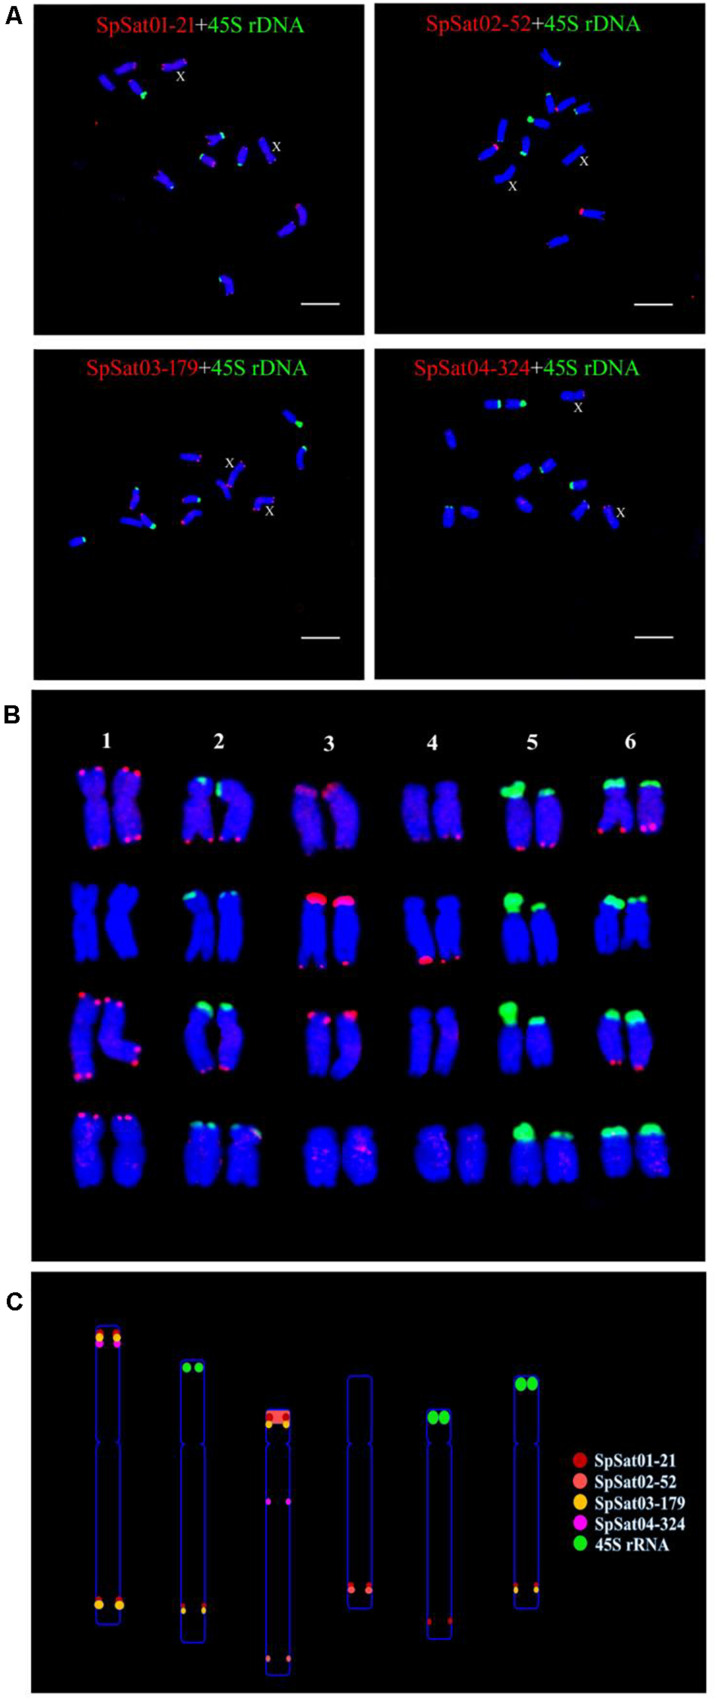
Karyotype and ideograph for spinach mitotic metaphase chromosomes. (A) FISH analysis of SpSat01-21, SpSat02-52, SpSat03-179, and SpSat04-324 (red), and 45S rDNA (green) on mitotic chromosomes. Arrows indicate the sex chromosomes. (B) Karyotype analysis of spinach based on the size and FISH signal pattern. (C) Ideogram shows the positions of SpSat01-21 (red), SpSat02-52 (yellow), SpSat03-179 (pink), SpSat04-324 (purple), and 45S rDNA (green). Bars = 10 μm.